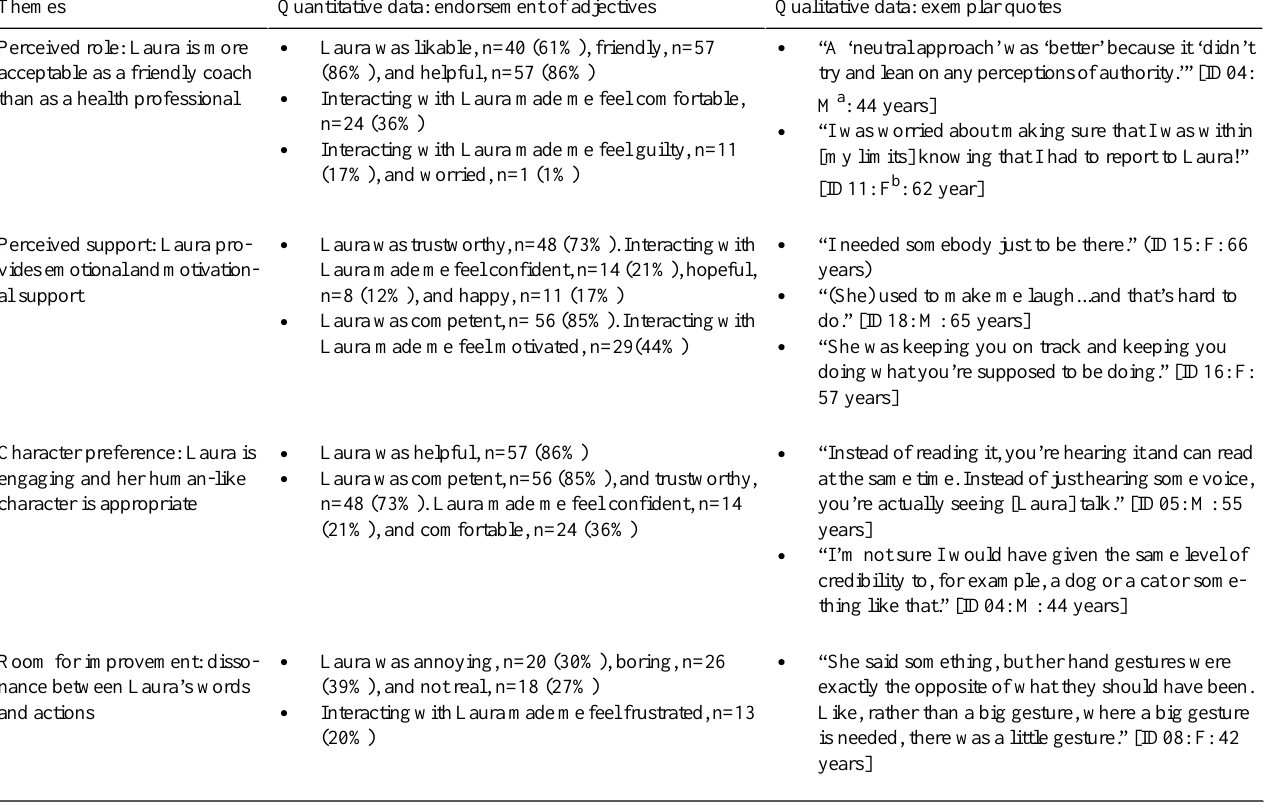
Table 2. Integrated results